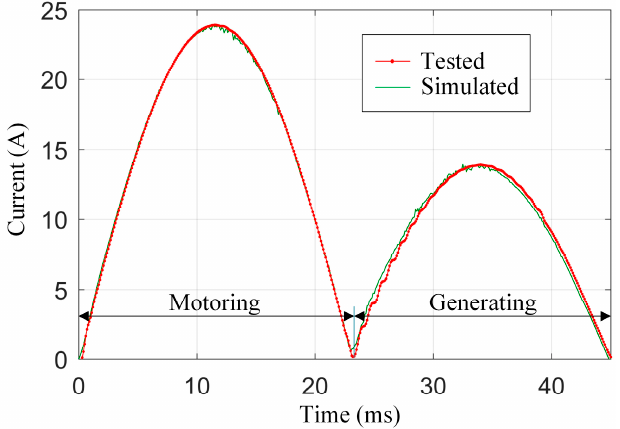
Figure 9. Comparison of tested and simulated current.